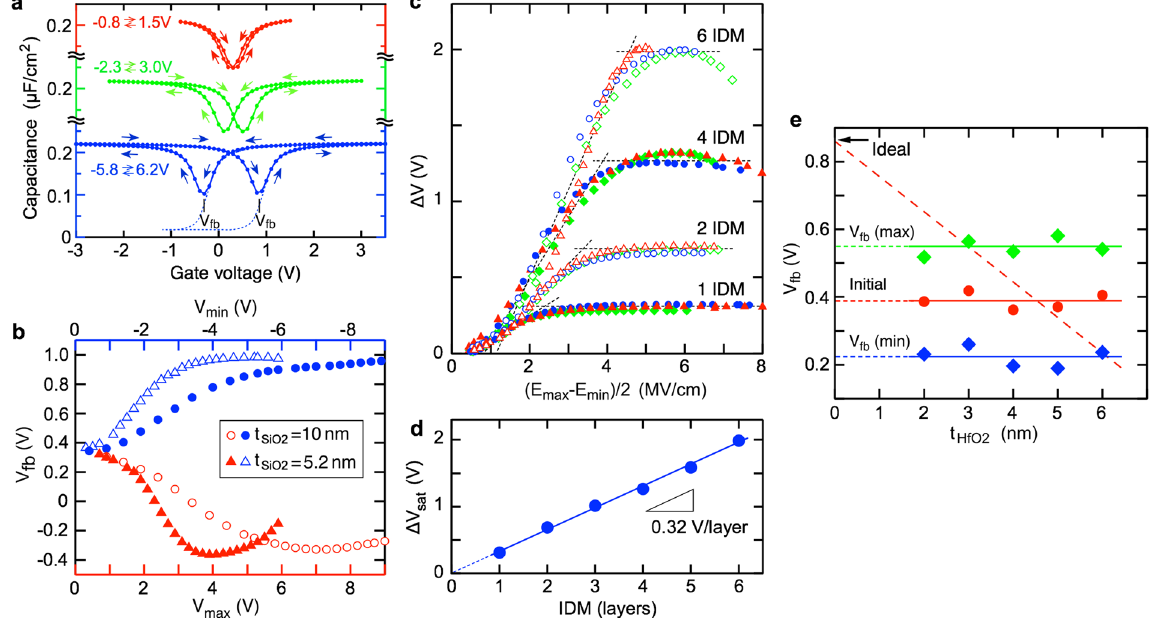
Figure 3. Hysteresis C-V characteristics of HfO 2 /SiO 2 IDM MOS capacitors. (a ) C-V curves of the four-stacked IDM MOS capacitor consisting of 3.5-nm-thick top HfO 2 , 1.8-nm-thick inner SiO 2 , 1.8-nm-thick inner HfO 2 , and 10-nm-thick bottom SiO 2 layers. Double sweep measurements are performed at 5 kHz under weak light illumination. Sufficient electric fields for both positive and negative bias ranges are produced in the oxide layers. ( b ) Bias dependence of the flat-band voltage ( V fb ) observed from the four-stacked IDM MOS capacitor. Sample with a thin bottom SiO 2 layer (5.2 nm) exhibits a V fb shift in the lower voltage range compared to a thick bottom SiO 2 layer (10 nm). This difference is almost canceled out in the electric field dependence (Supplementary Fig. 3a), suggesting that the IDM operation is a field driven process. ( c ) Dependence of the modulation width on electric field. Modulation width ( Δ V ) is the difference between the V fb values of the forward and backward voltage sweeps. ( d ) Dependence of the saturation modulation width, Δ V sat , on the number of IDM layers. The TiO 2 modulator has an ability to modulate the interface dipole by 0.32 V. ( e ) Dipole modulation width of a single IDM structure as a function of HfO 2 thickness. Initial V fb , maximum V fb , and minimum V fb values are not affected by the top HfO 2 thickness (t HfO2 ). This result suggests that the change in the interface dipole dominates the observed voltage